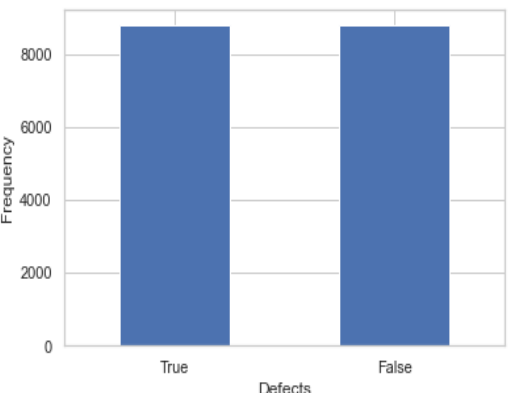
Figure 3. Transaction class against the frequency after implementing the resampling method.